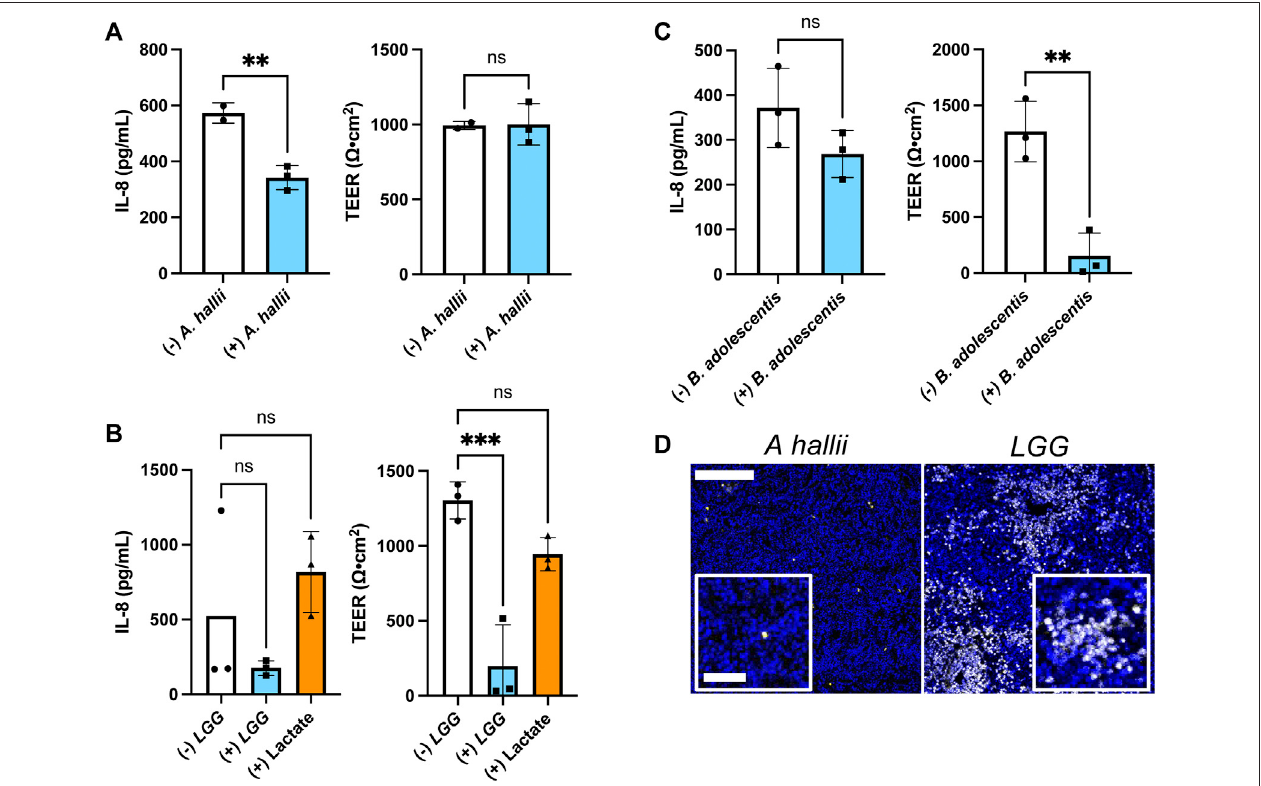
FIGURE 4| Impact ofbacteriaon IL-8 secretion by in fl amed intestinal epithelium from donor 2 (A – C) IL-8 secretion and TEER measured after 24 h co-culture with and without (A) A. hallii , (B) LGG , or (C) B. adolescentis . 5 × 10 4 CFU/mL of bacteria was inoculated onto each sample. The bars represent the average of the measurements,andtheerrorbarsindicatethestandarddeviationofthedata. n =3technicalreplicatesforalldata.* p ≤ 0.05;** p < 0.01;ns.notsigni fi cantlydifferent. (D) Fluorescence of human colon epithelial cells stained with PI (yellow) and Hoechst 33,342 (blue) after co-culture with A. hallii and LGG for 24 h. Scale bar = 100 μ m (50 μ m in the